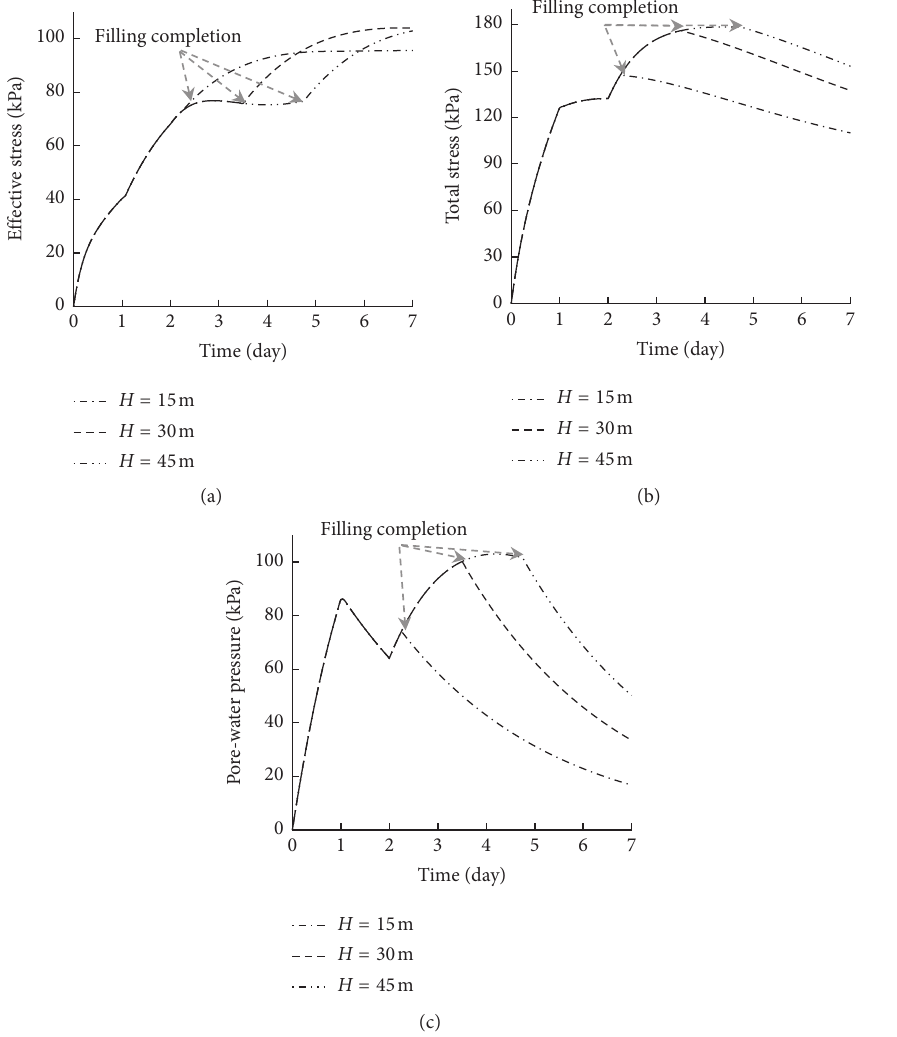
Figure 7: Effect of stope geometry on the variation of internal stress: (a) effective stress; (b) total stress; (c)